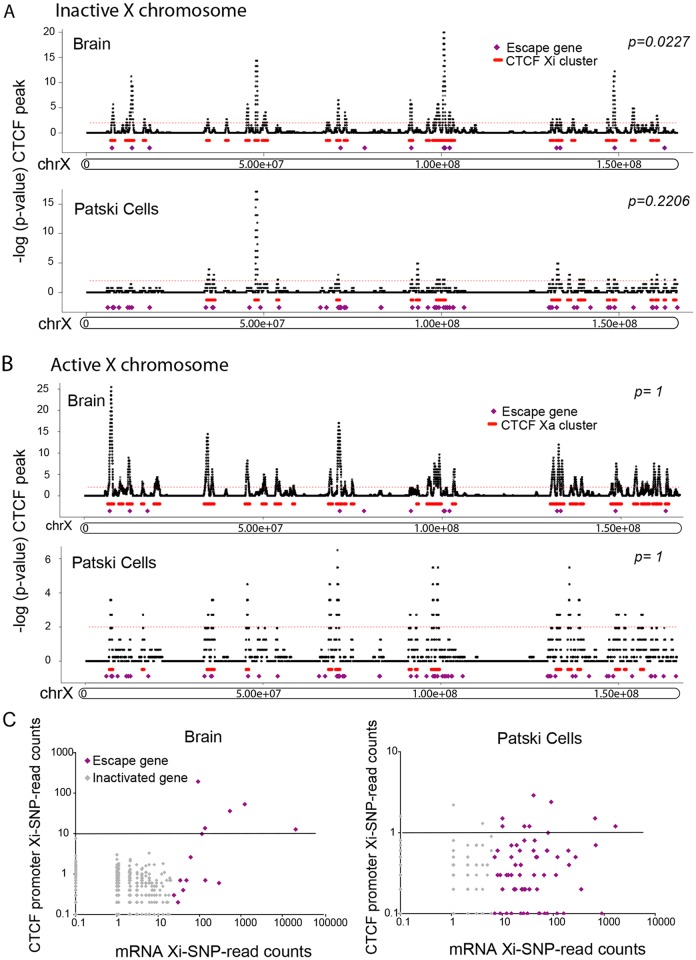
Xi-associated but not Xa-associated CTCF peak clusters co-localize with escape regions.(A) Significant CTCF Xi-binding clusters were mapped along the Xi in brain and Patski cells. Xi- and both-preferred peaks were determined by a binomial model and used for density analysis. Red bars represent merger of clusters of CTCF Xi-binding peaks, while purple dots represent escape genes. Significant Xi-binding CTCF binding clusters tend to co-localize with chromatin containing escape genes. Little change was seen after removal of promoter-associated CTCF binding (S3B Fig). Horizontal axis represents the Xi in Mb. The vertical axis is the negative log of the calculated binomial p-value (-log (p-value)). The thin red dashed line represents a 0.01 p-value cutoff. (B) Similar analysis for CTCF Xa- and both-preferred peaks. There was no significant CTCF co-localization with escape genes on the Xa in either brain or Patski cells. (C) Average CTCF Xi-SNP read counts in ten 100bp windows at promoters (0.5kb upstream and downstream of the TSS) is plotted against mRNA-seq Xi-SNP read counts escape genes (purple) and for genes subject to XCI (gray) in brain and Patski cells. In brain, a higher proportion of escape genes (6/14; Fisher’s exact test, p = 5e-9) had an average ≥10 reads (black line) at their promoter compared to genes subject to XCI (0/403). Similarly, in Patski cells a higher proportion of escape genes (9/65; Fisher’s exact test, p = 0.0004) had an average of ≥1 read (black line) at their promoter compared to genes subject to XCI (3/204).